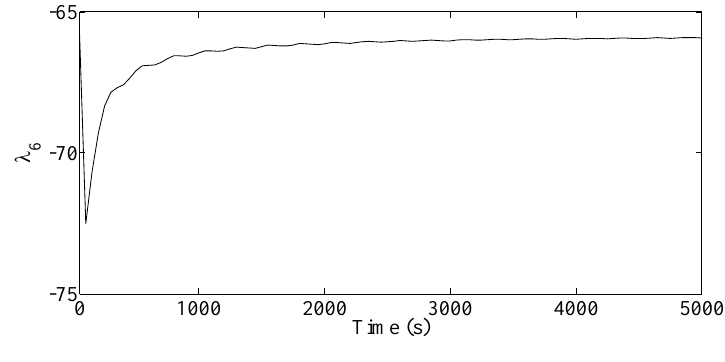
Figure 5. Time evolution of